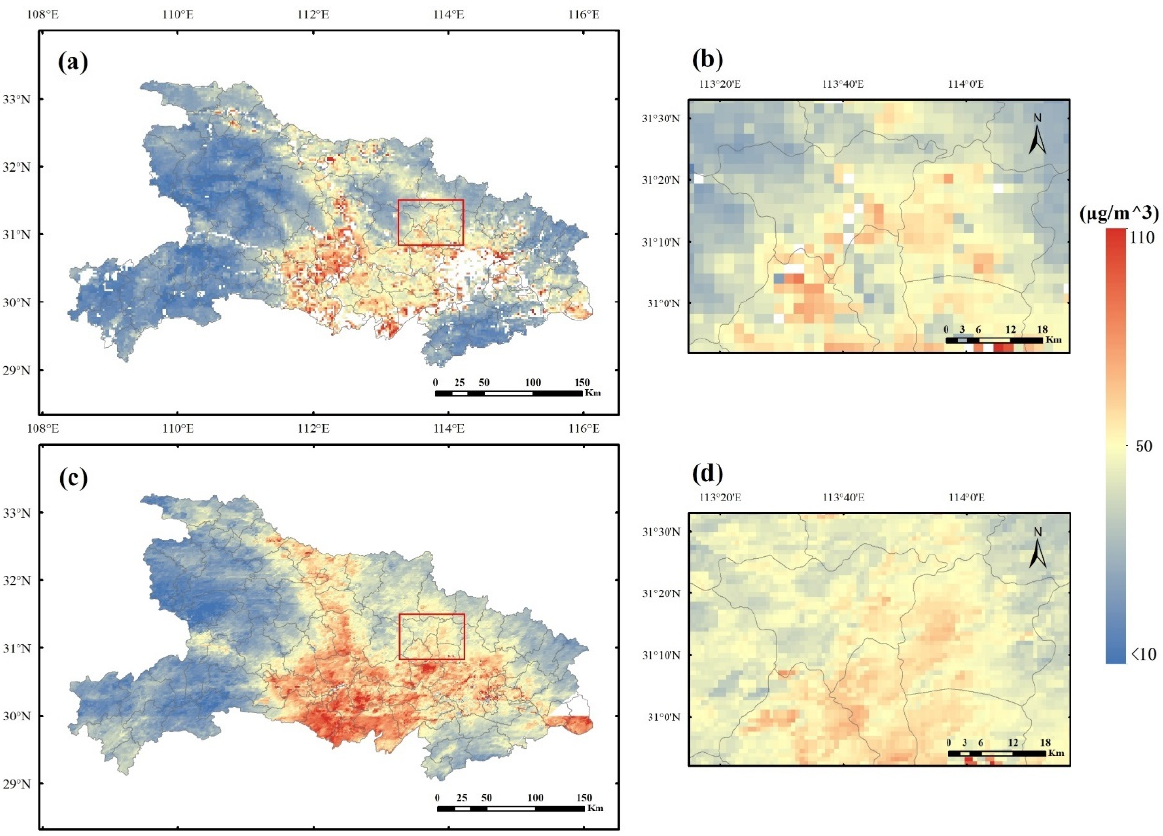
Figure 4. Spatial resolution comparison of the annual 1 km PM 2.5 derived from MAIAC AOD ( a ) and 3 km PM 2.5 derived from MODIS AOD ( c ) in Hubei Province in 2017. When the map is zoomed to a smaller scale, the spatial advantages of the 1 km PM 2.5 are displayed by comparing the MAIAC-derived ( b ) and MODIS-derived ( d ) PM 2.5 concentrations.